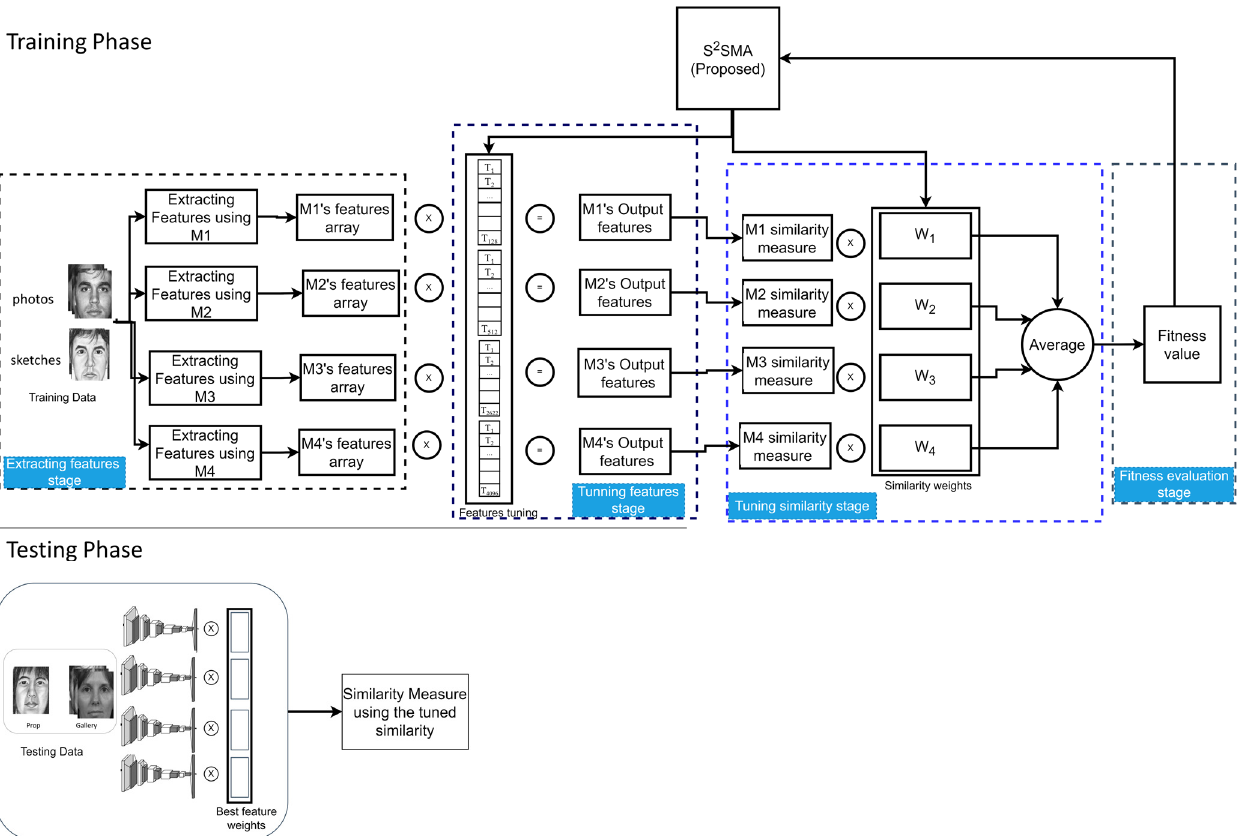
Figure 9. The illustration shows the suggested technique for face sketch recognition using multiple models. The upper portion represents the training phase, while the lower portion represents the testing phase.